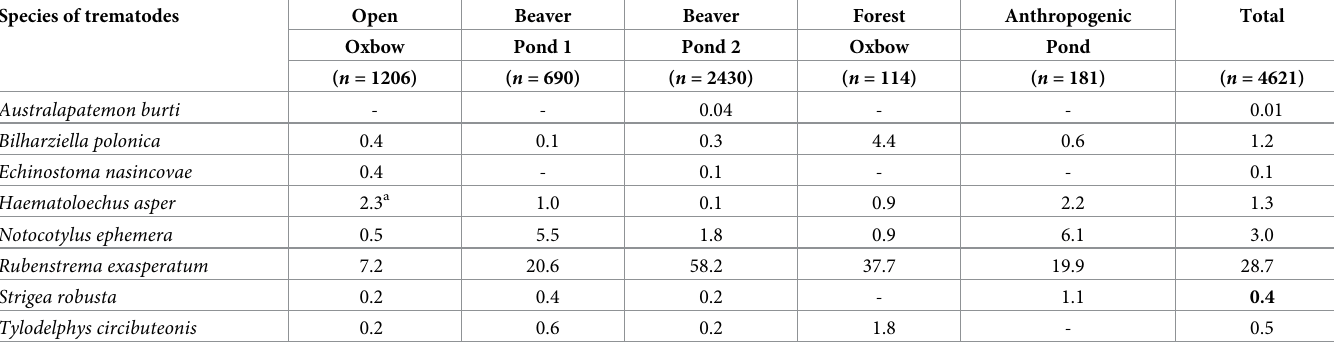
Table 3. Occurrence of trematode species in Planorbarius corneus ( n = 4621). Species of trematodes